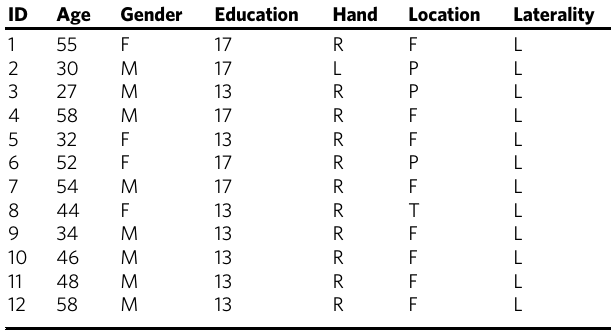
Table 1 Socio-demographical and clinical